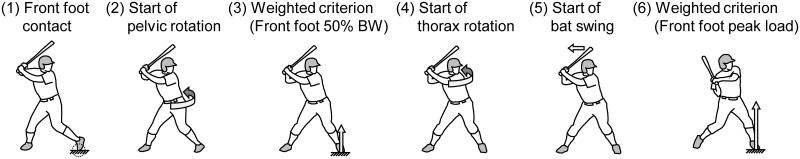
Six hitting events during a swing.